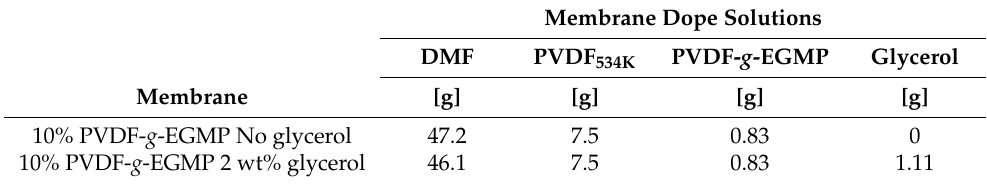
Table 1. Compositions of the dope solutions prepared for casting poly(vinylidene fluoride) (PVDF) membrane composed of 10% PVDF- g -EGMP (ethylene glycol methacrylate phosphate) in dimethyl- formamide